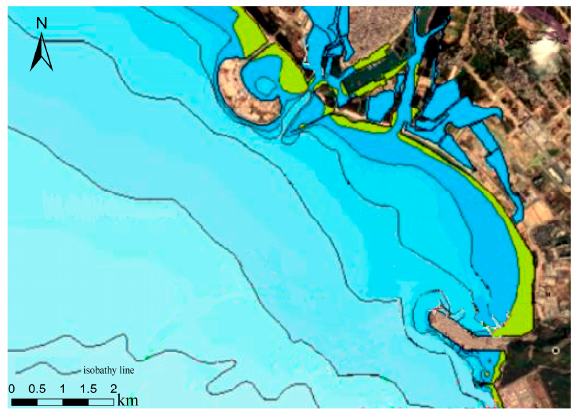
Figure 8. Isobath map of Nanshan Port